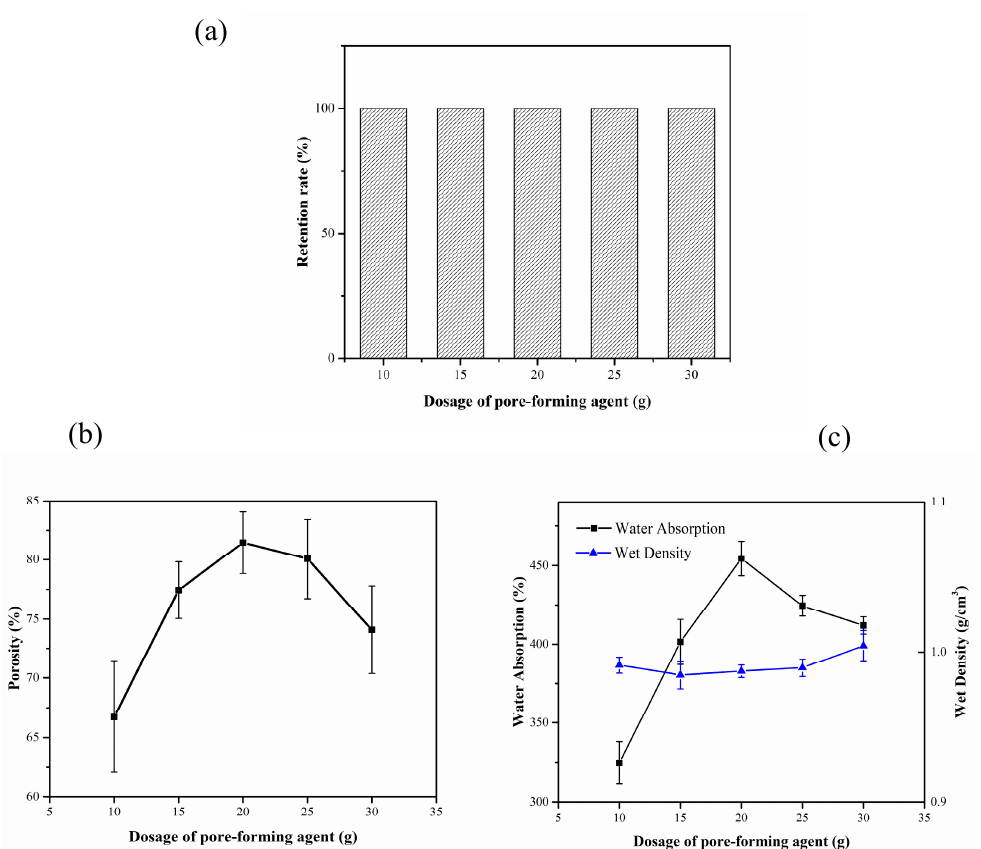
Figure 4. Effect of pore-forming agent dosage on the properties of composite carrier. ( a ) Effect of the dosage of pore-forming agent on retention rate; ( b ) Effect of the dosage of pore-forming agent on porosity; ( c ) Effect of the dosage of pore-forming agent on water absorption and wet density.